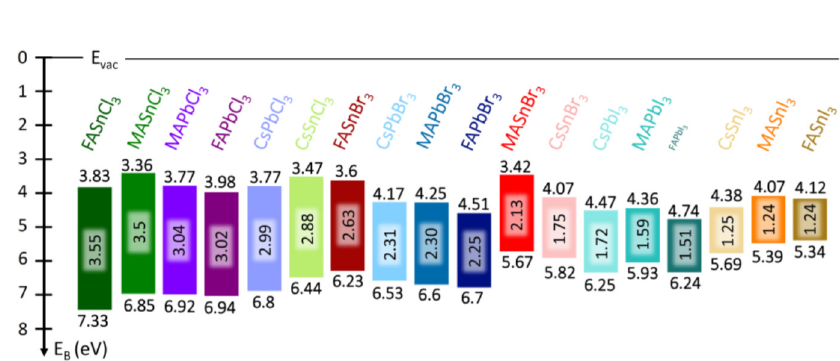
Fig. 12. – Energy levels of different perovskite compositions